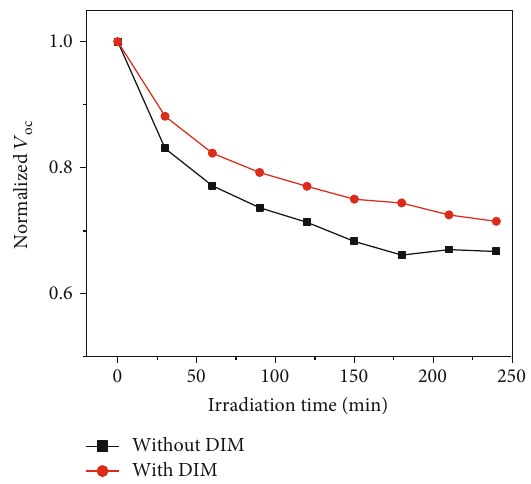
Figure 10: Normalized V oc of the PCDTBT:PC 71 BM solar cell processed without and with 3% DIM as a function of irradiation (100mW/cm 2 ) time at ambient air.